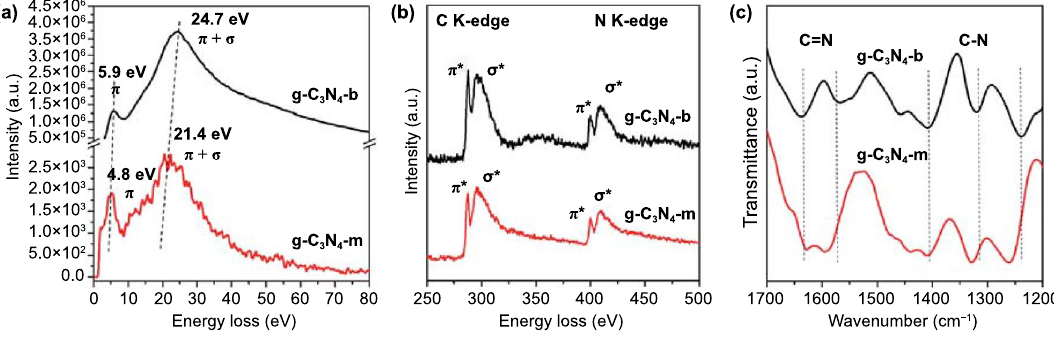
Fig. 5 EELS and FT‑IR spectra for g‑C 3 N 4 –b and g‑C 3 N 4 –m. a Low‑loss and b core‑loss range spectra of EELS for both g‑C 3 N 4 –b and g‑C 3 N 4 –m, respectively. The EELS spectra were normalized with respect to the integrated intensity of the negative energy‑loss part of zero loss peak (ZLPs). c FT‑IR spectra of g‑C 3 N 4 ‑b and g‑C 3 N 4 –m in the range of the C–N and C = N bonds